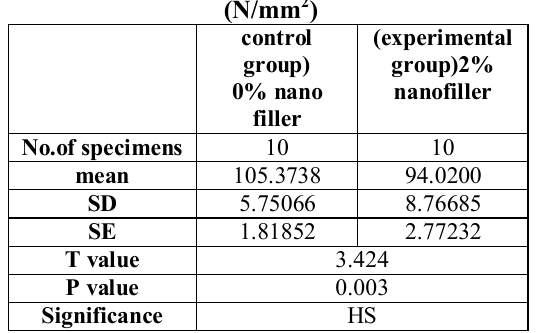
Table 2: Transverse strength test results in